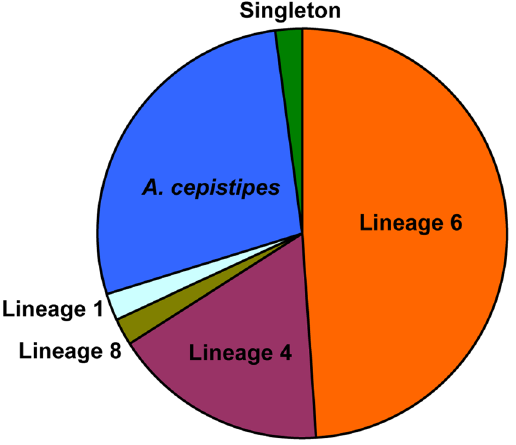
Figure 2. Relative abundance of the phylogenetic lineages of the forty seven Armillaria isolates.